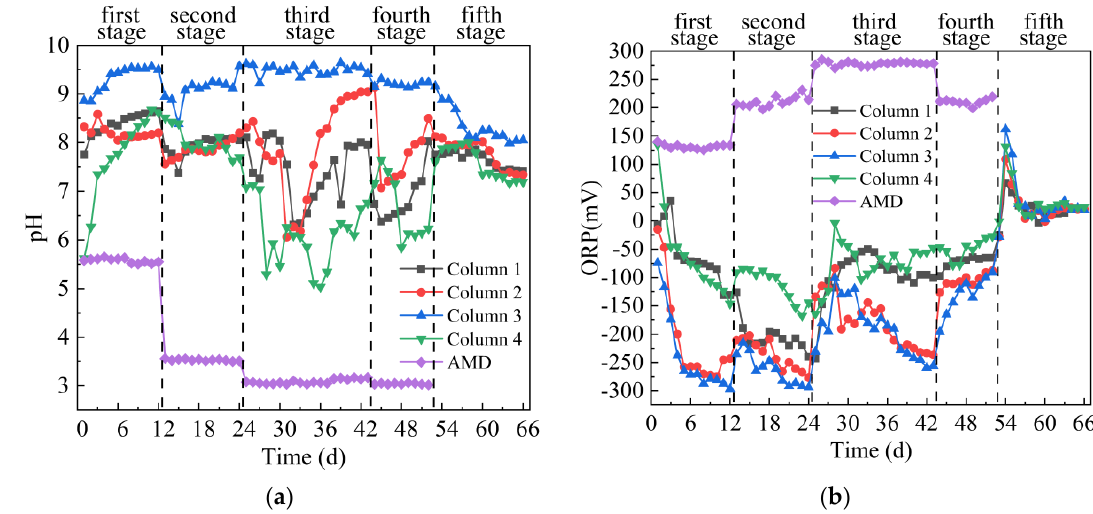
Figure 3. Changes of pH and ORP values of sulfate-reducing bacteria (SRB) combined with Coal Gangue 1–4 to repair acid mine drainage (AMD). ( a ) pH value; ( b ) ORP value.